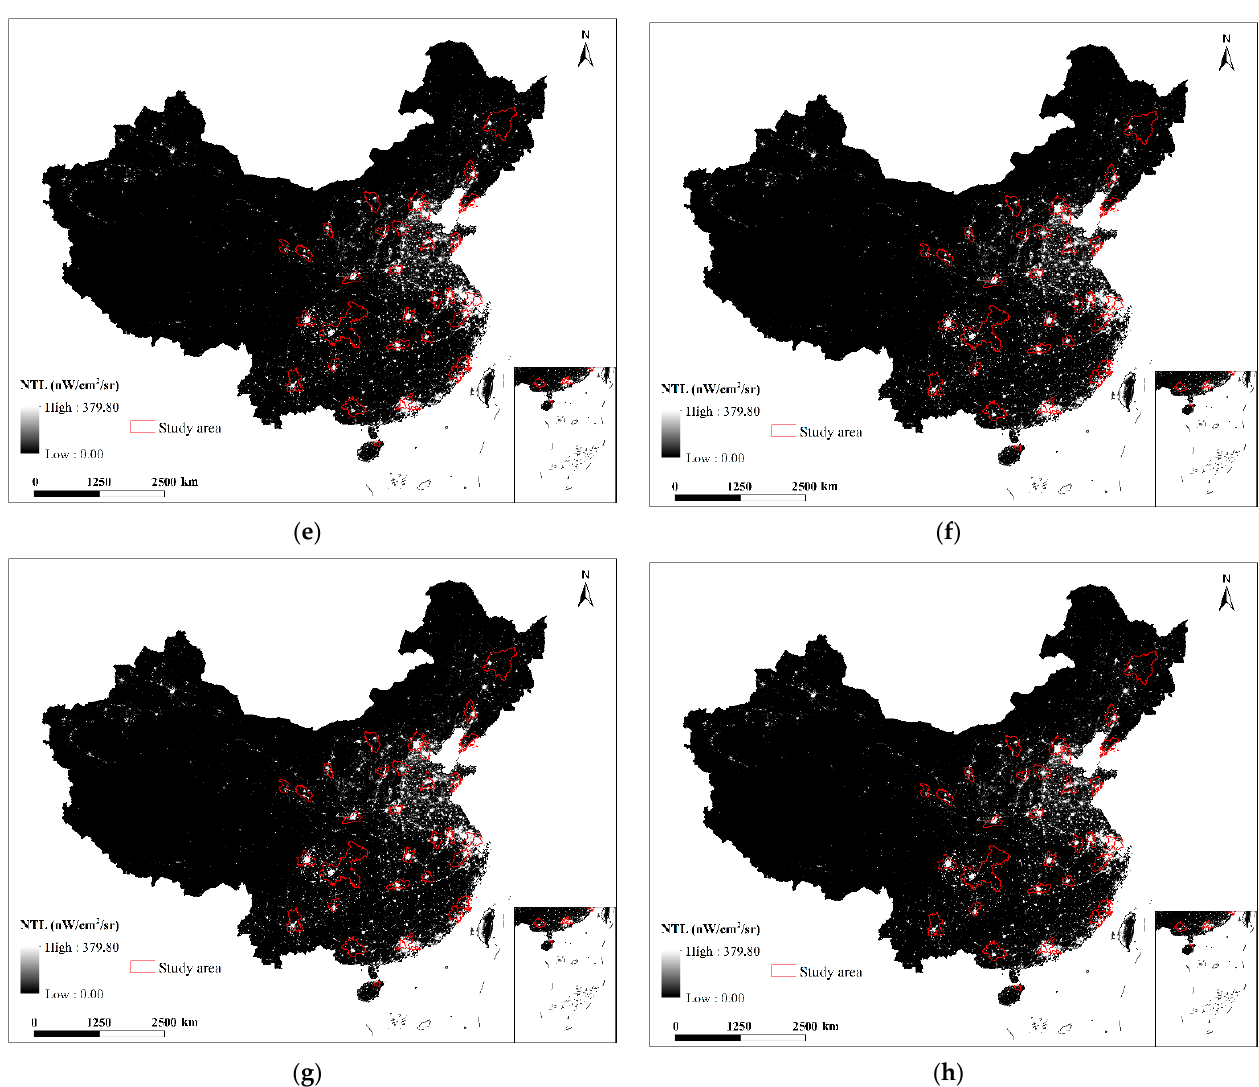
Figure 4. ( a , b ) are the NTL brightness changes of the secondary and tertiary industries from December 2019 to June 2020, respectively; ( c – h ) are the NTL images from January to June 2020.